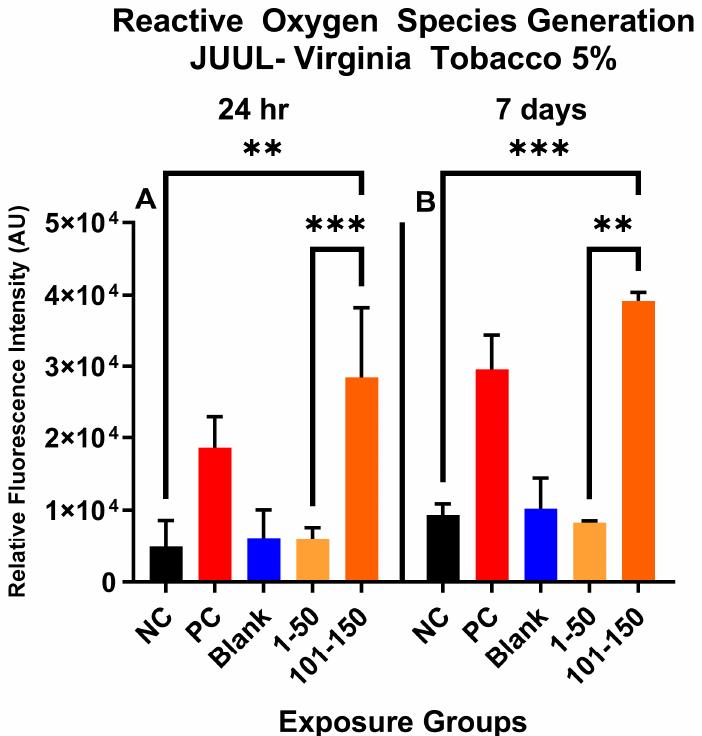
Figure 2. Quantitative data analysis of ROS generation in SAEC after 24 h ( A ) and 7 days ( B ) exposure at two puff fractions (1–50) and (101–150). After 24 h of exposure, there was a significant increase (***, p < 0.001) in ROS generation at the later puff fraction (101–150) compared to negative control ( A ). There was significantly higher (**, p < 0.01) relative fluorescence intensity detected in the 101–150 puffs than the 1–50 puffs at 24-h ( A ). Similarly, after 7 days of repeated exposure, the later puff fraction (101–150) elicited significantly higher (**, p < 0.01) ROS than the 1–50 puff fraction ( B ).